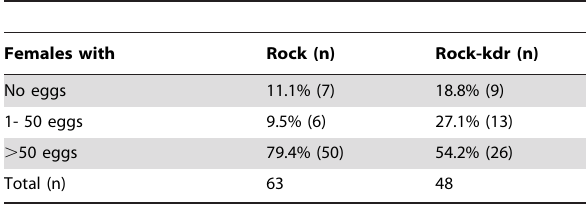
Table 1. Oviposition performance of Rockefeller and Rock- kdr Ae. aegypti females.